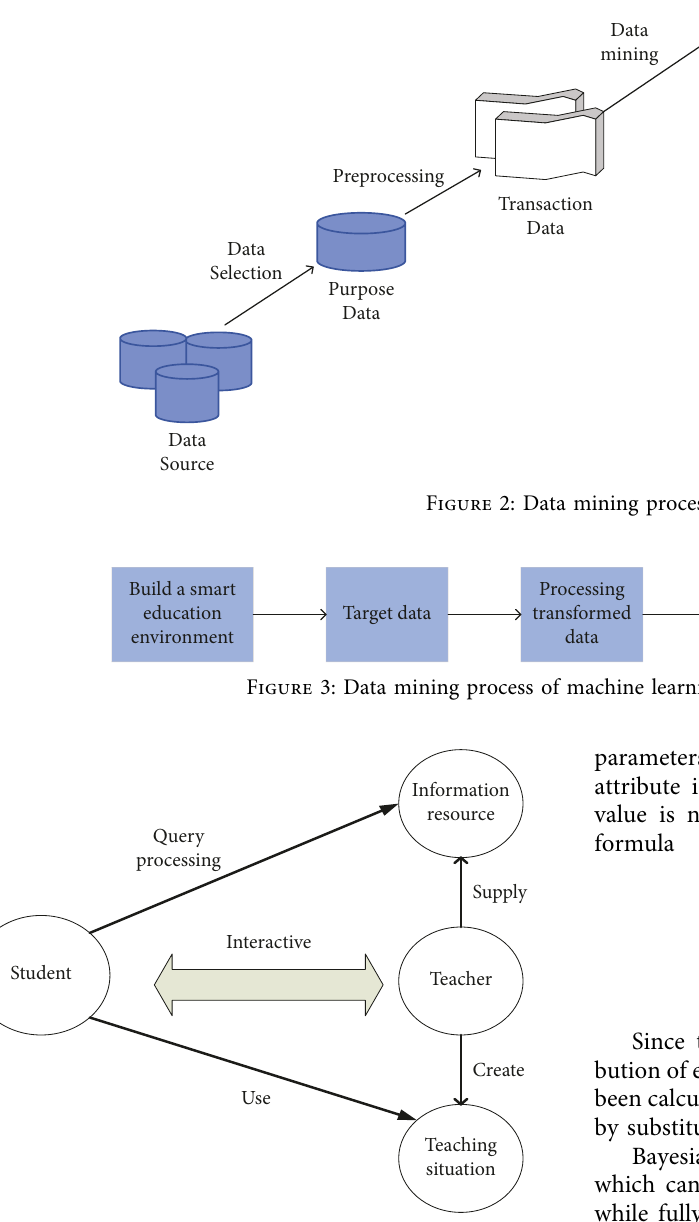
Figure 4: Teaching mode of educational informatization.